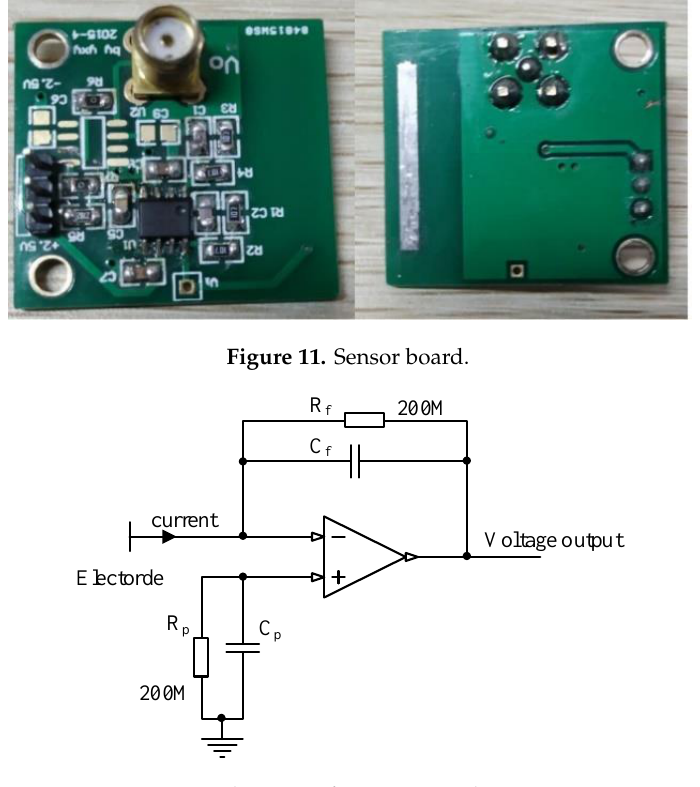
Figure 12. Schematic of current-to-voltage circuit .